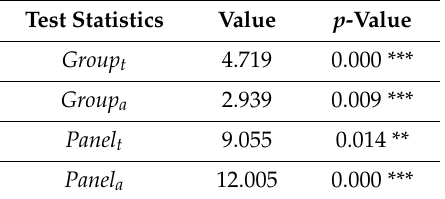
Table 5. Westerlund Panel cointegration